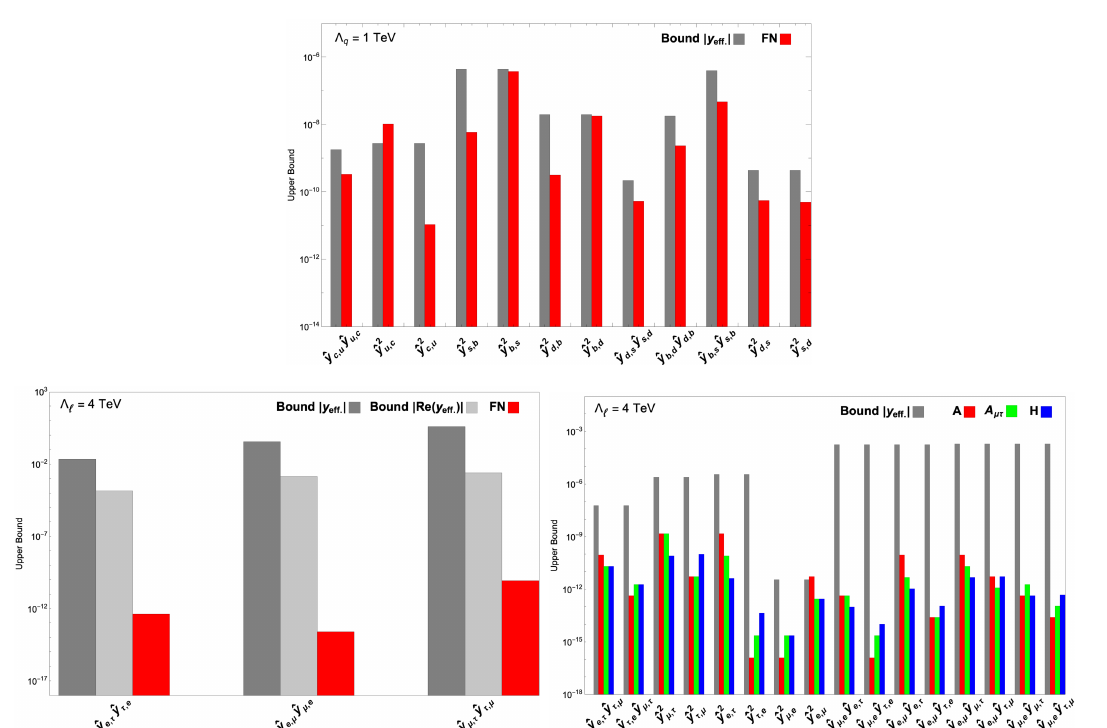
Figure 3 . Graphical representation of the experimental bounds and FN predictions on the effective Yukawas for the CP conserving case. In the first plot the results in the quark sector: in grey the bounds on the absolute value of the combination of the effective Yukawas from table 10, and in red the prediction of the FN model assuming Λ q = 1 TeV. The second plot shows the results in the lepton sector when the combination of the effective Yukawas do not depend on the FN charge assignment: in the dark (light) grey the bounds on the absolute value (real part) from table 11, while the FN predictions are in red assuming Λ ‘ = 4 TeV. The last plot still refers to the lepton sector and to the effective Yukawas that do depend on the FN charge assignment: in grey there are the bounds on the absolute value from table 11, in red the Anarchical model, in green the A µτ model and in blue the hierarchical model for Λ ‘ = 4